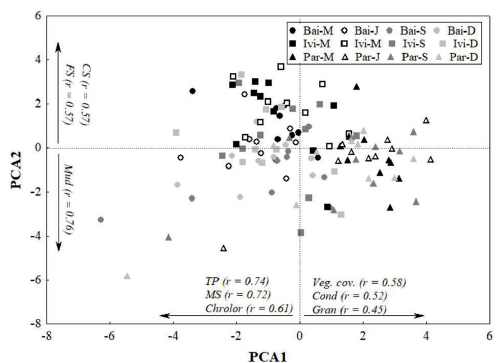
Figure 2. Principal Component Analysis Ordination showing the eigenvectors of environmental variables that most influenced axes 1 and 2. Legend: Bai = floodplain lakes system of Baía River; Ivi = floodplain lakes system of Ivinhema River; Par = floodplain lakes system of Paraná River; M = March; J = June; S = September; D = December. Inside of the graph: Cond. = conductivity; Chloro. = chlorophyll-a; gran. = Granules; CS = coarse sands; MS = medium sands; FS. = fine sands; Veg. cov. = vegetation cover; TP = total